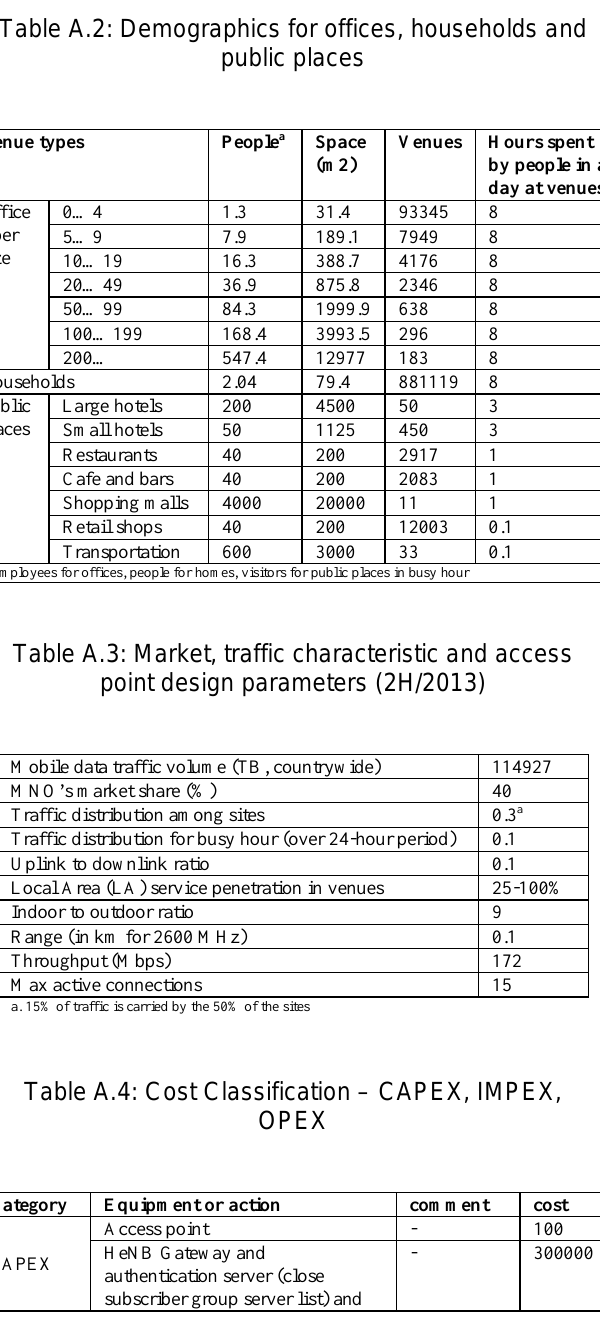
Table A.2: Demographics for offices, households and